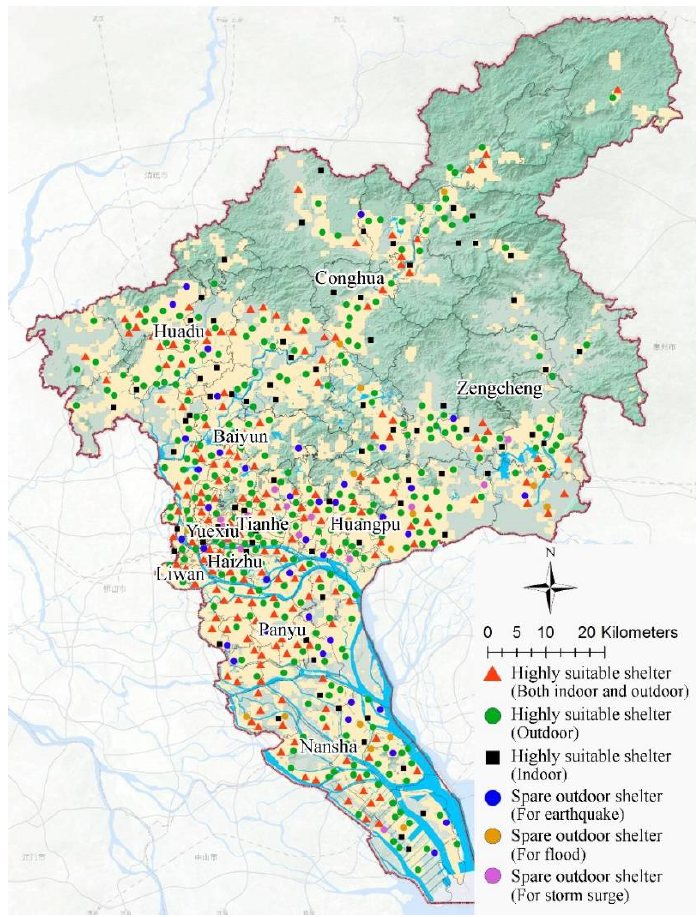
Figure 8. Allocation of emergency shelters in a multi-hazard environment.